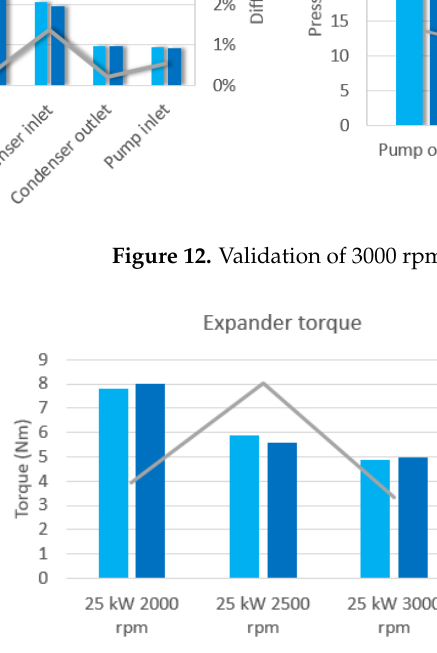
Figure 13. Validation of torque.